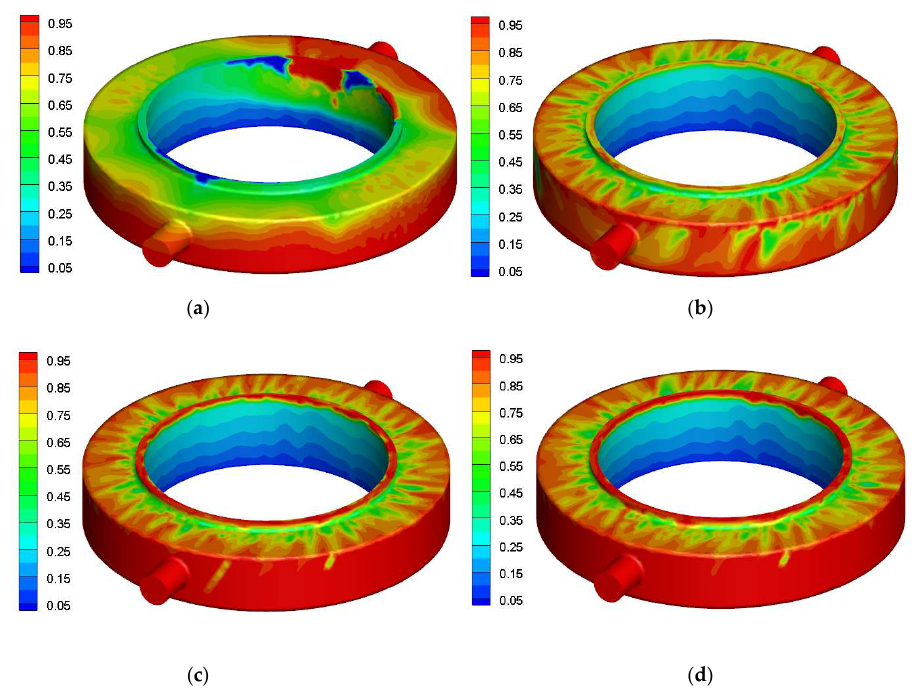
Figure 6. Oil droplet volume fraction (%) at different time with diameter in the range of 56 to 80 μm when the air inflow is 12 g/s, oil inflow is 15 g/s, and initial oil droplet diameter is 28 μm (the oil inlet is on the bottom, the vent is in front and the z axial direction is up). (a) t = 50 ms; (b) t = 100 ms; (c) t = 200 ms; (d) t = 400 ms.